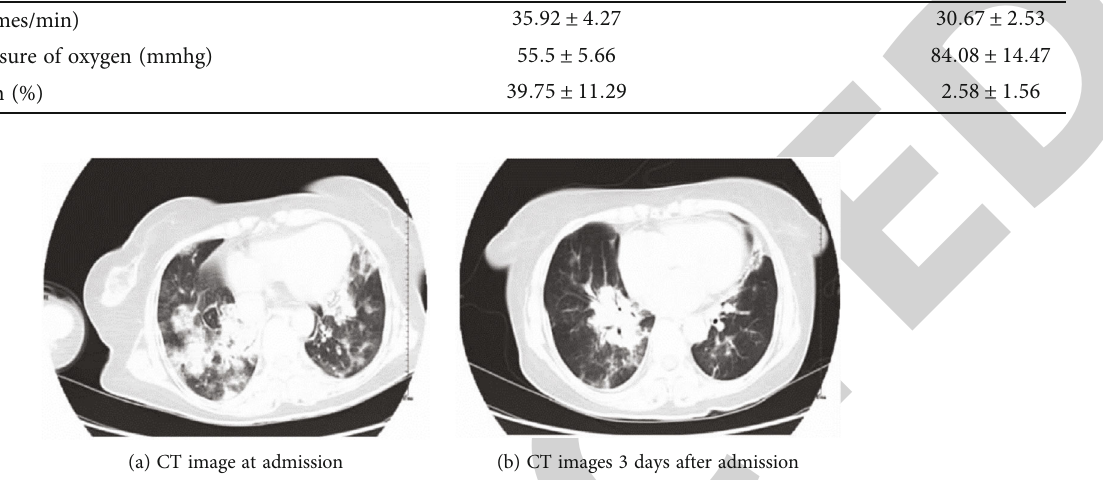
Figure 2: CT image of lung in patients with carbon monoxide poisoning and aspiration pneumonia. Table 2: Comparison of nursing e ff ect between the two